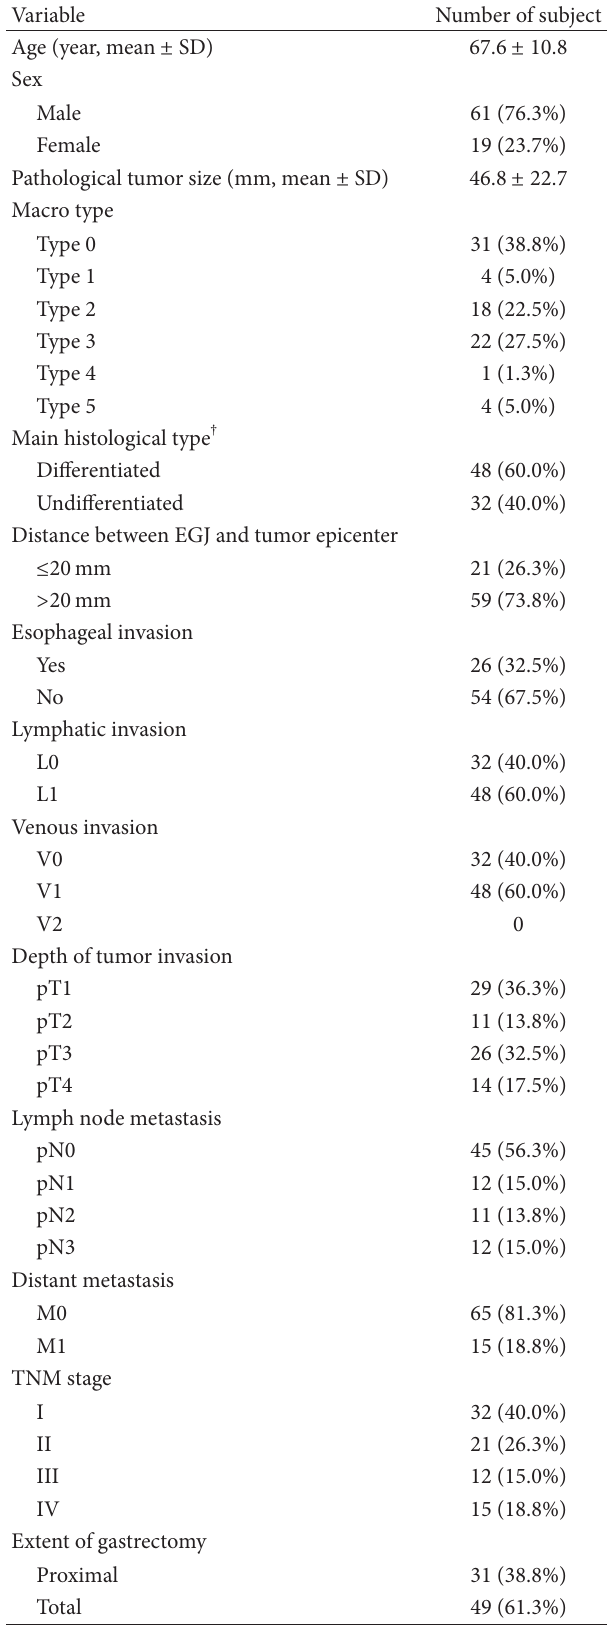
T 1: Clinicopathological characteristics of patients